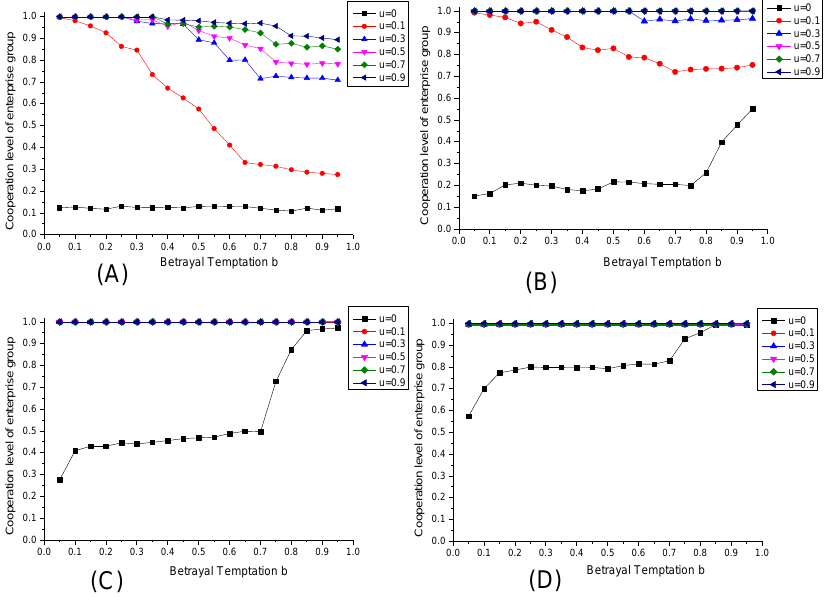
Figure 5. The evolutionary equilibrium under di ff erent reputation evaluation intensity. Note: α = 0.1, and ( A ) r = 0.1; ( B ) r = 0.3; ( C ) r = 0.5; ( D ) r = 0.7.